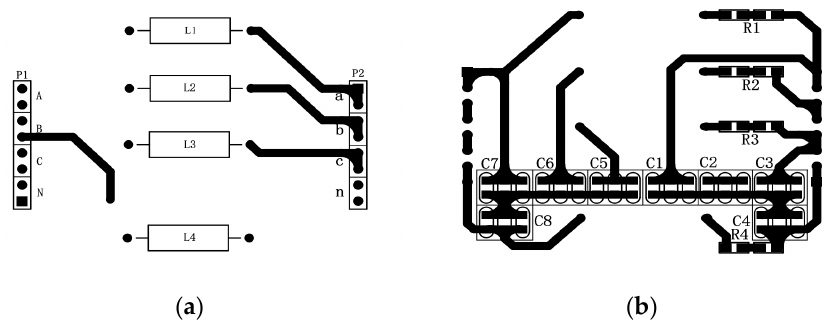
Figure 5. Layout of the three-phase distribution line printed circuit board (PCB) module: ( a ) obverse side; and ( b ) reverse side.